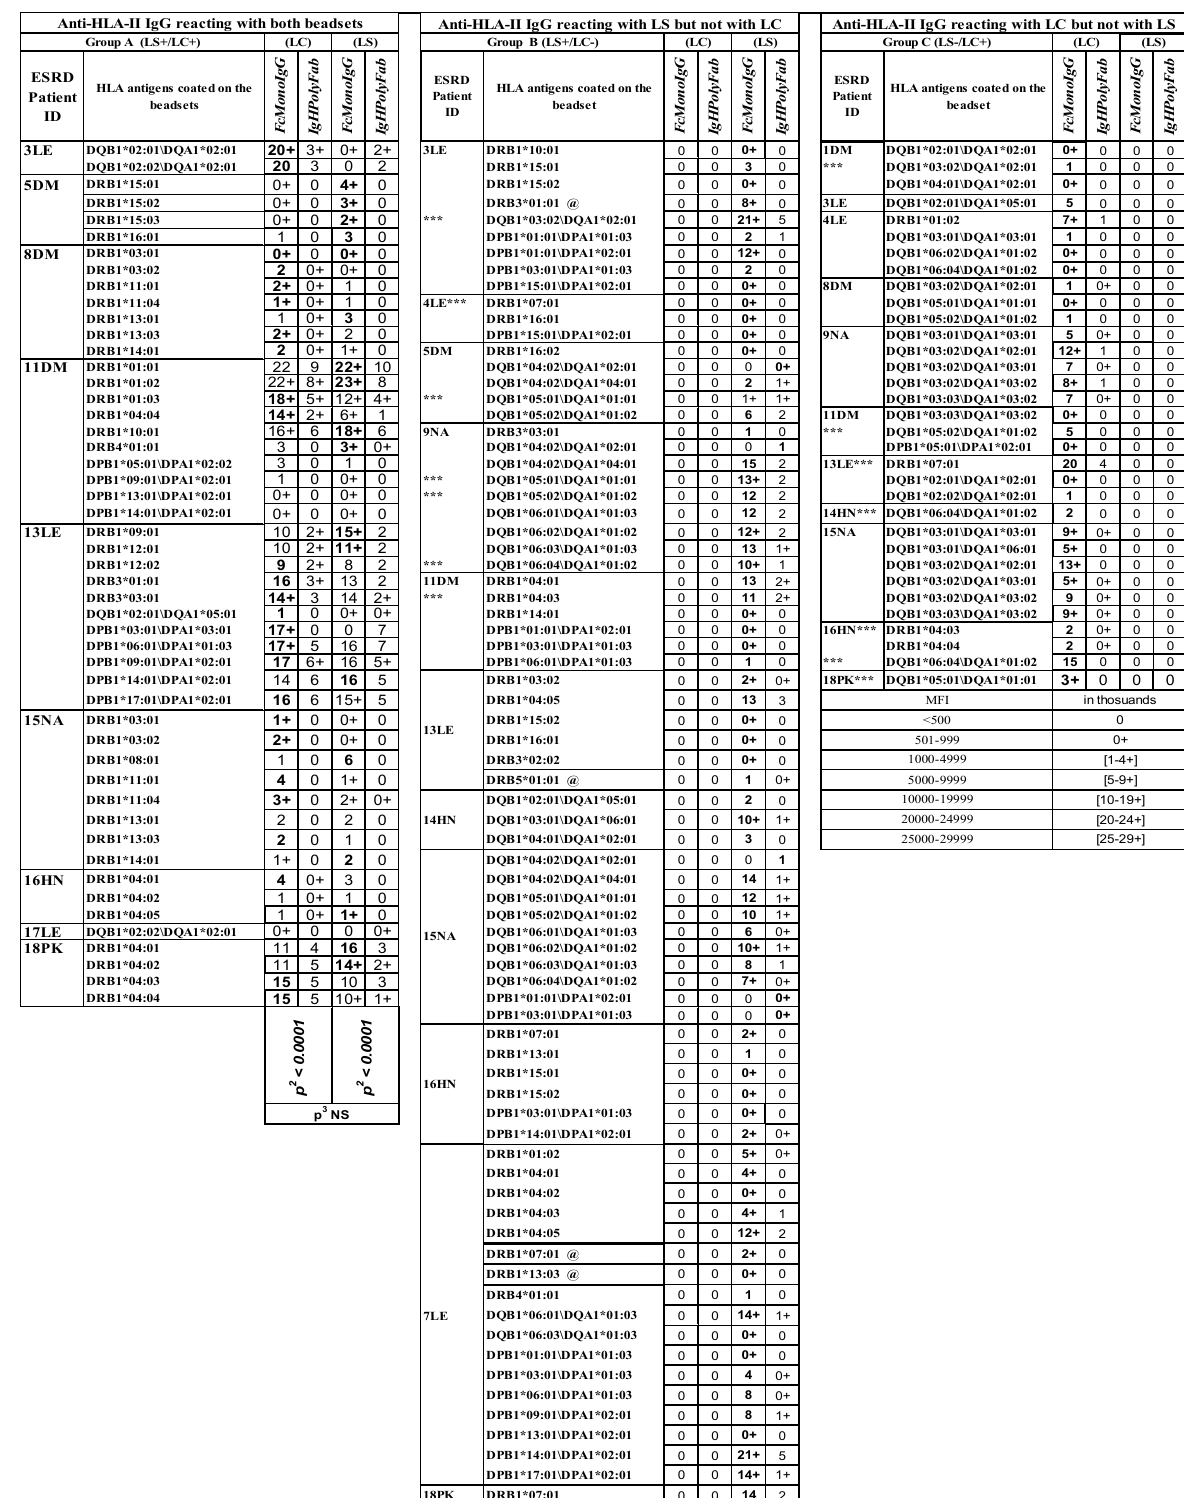
Anti-HLA-II IgG reacting with both beadsets Anti-HLA-II IgG reacting with LS but not with LC